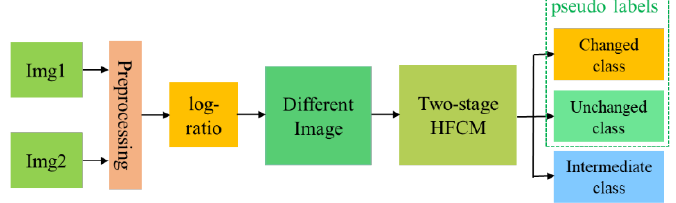
Figure 1. Generation of pseudo-labels of multi-temporal SAR images.